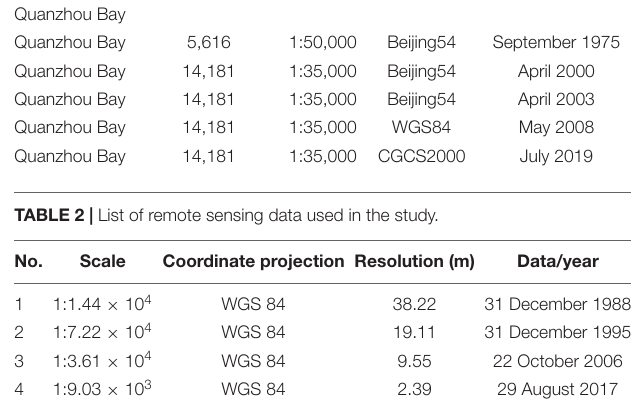
extracted from remote sensing (Li et al., 2018b), changes in the isobath and coastline were analyzed, and the rates of erosion and deposition were obtained to determine the evolutionary processes in the regional topography.